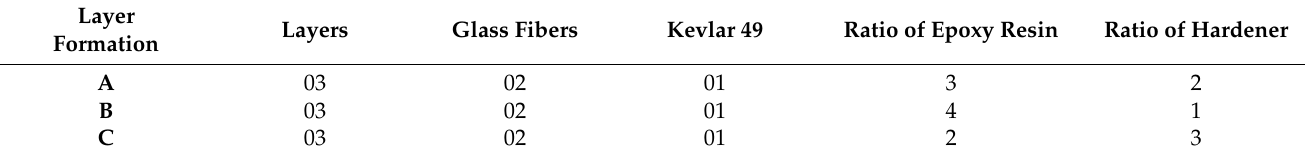
Table 2. Materials properties of E-glass, Kevlar, and epoxy.